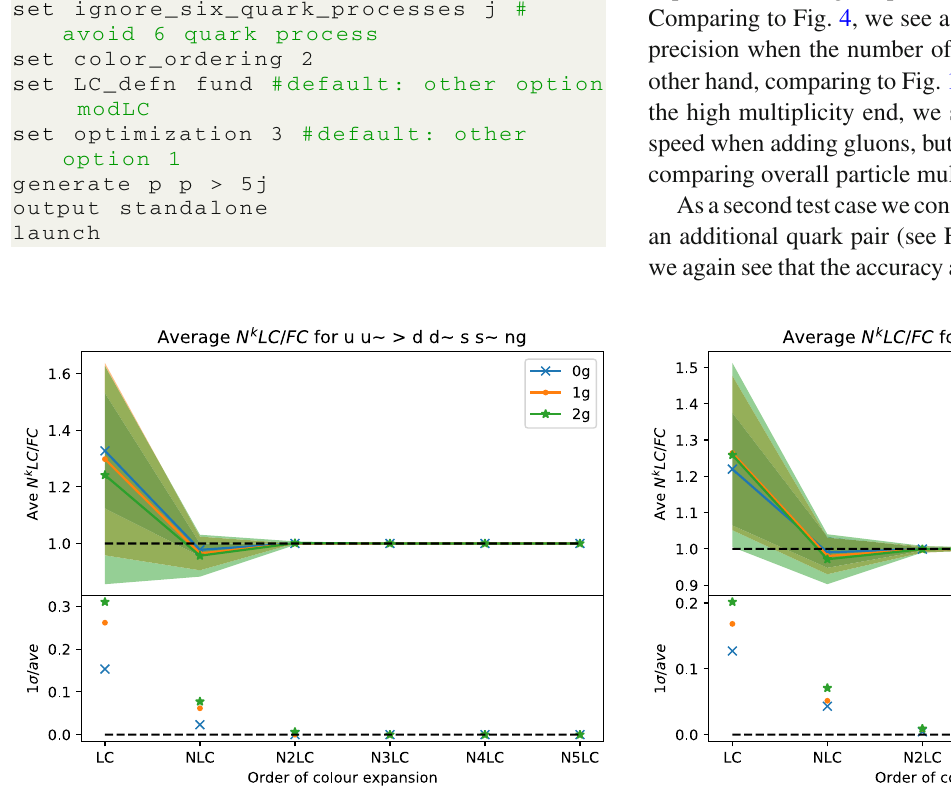
Fig. 14 Same as Fig. 3 but for the processes u ¯ u → d ¯ ds ¯ s + ng and u ¯ u → u ¯ uu ¯ u +